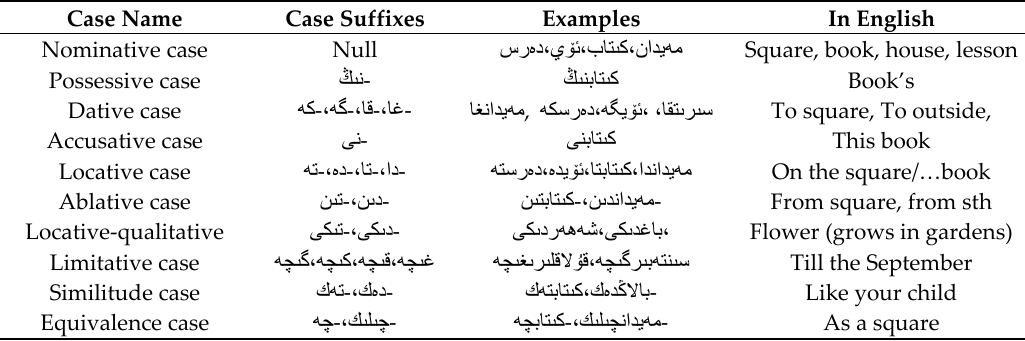
Table 2. Suffixes of the case category.